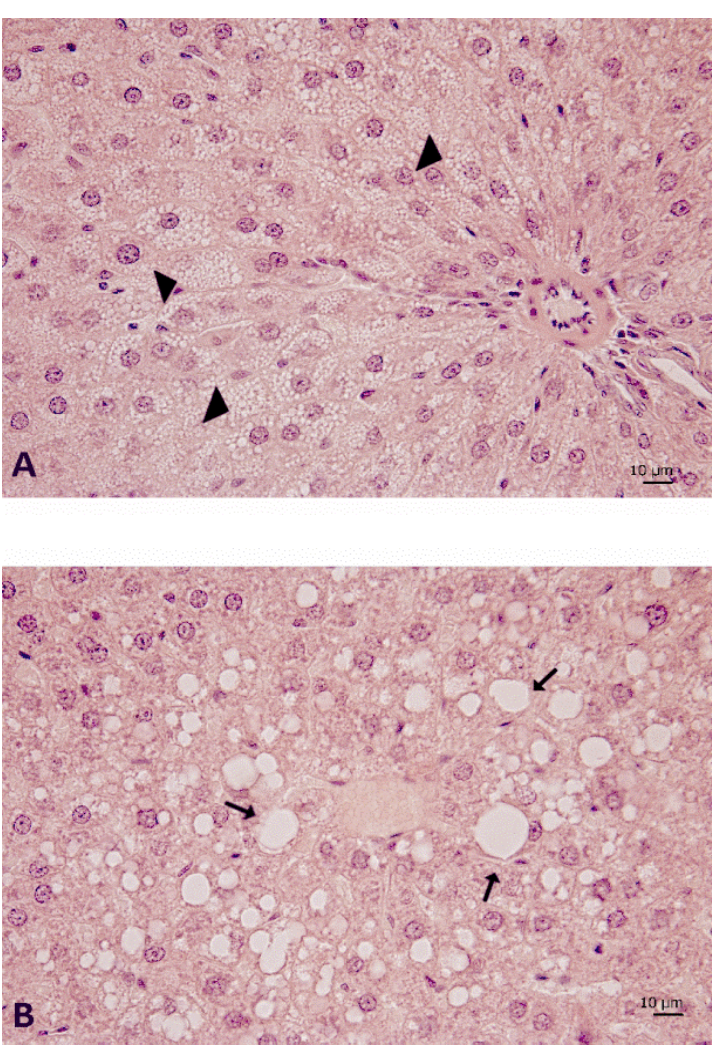
Figure 6. Liver morphology of DIO rats. Sections of liver processed for haematoxylin and eosin staining to highlight the ( A ) microvesicular steatosis, mainly found in the periportal areas (arrow head), and ( B ) macrovesicular steatosis (arrow), in a centrilobular area where several scattered balloon cells can be often observed. Magnification 40 × . Calibration bar: 10 µ m. DIO—diet-induced obese rats.